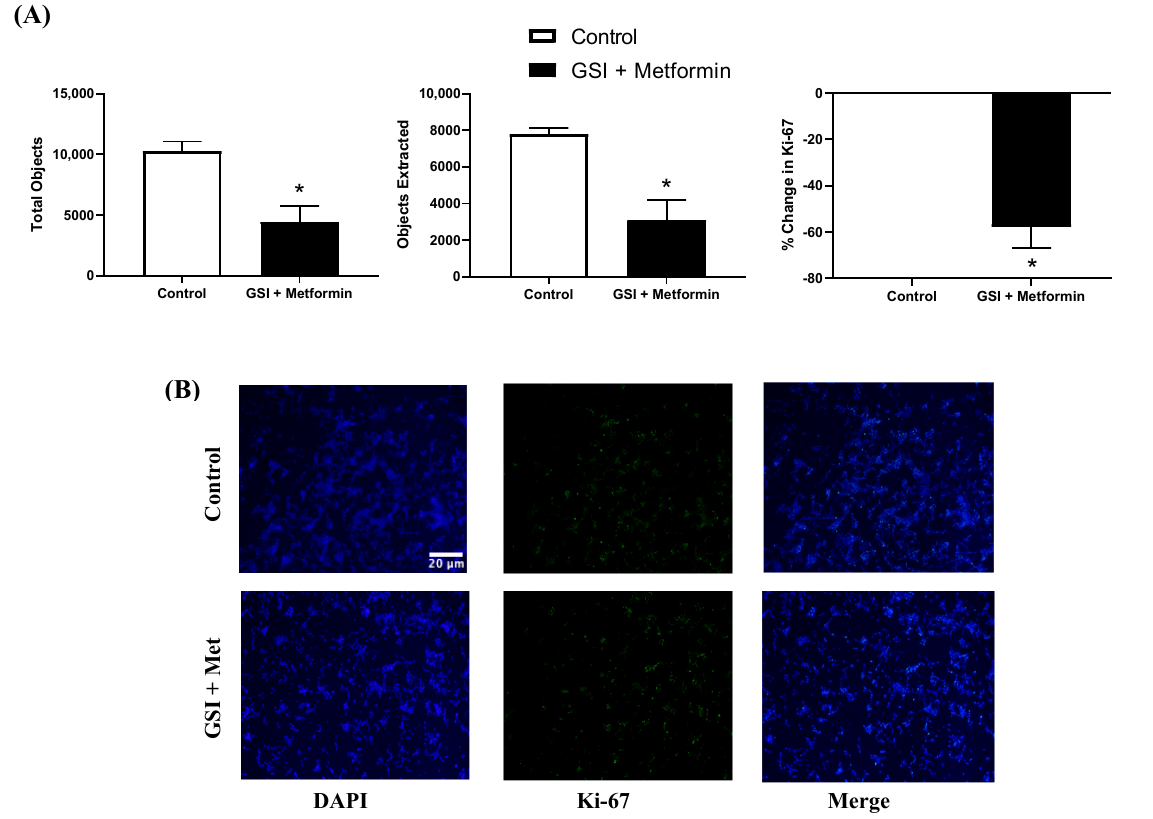
Figure 8. Ki-67 immunofluorescence in Lewis lung carcinoma cells treated with GSI and 10 mM metformin. ( A ) Total objects and objects extracted using binary feature extractor via Fiji. Percent change in Ki-67 expression relative to control in 48 h LL/2 cells treated with or without 10 mM metformin and 4 µM Ɣ -secretase inhibitor (GSI) every 12 h. * p = 0.02 vs. control (n = 3). ( B ) Representative immunofluorescence images of LL/2 cells treated with or without 10 mM metformin using 4’,6-diamidino-2-phenylindole (DAPI) and Ki-67 expression visualized via AlexaFluor 488. Representa- tive images were taken at 10x. Scale bar = 20 µm.